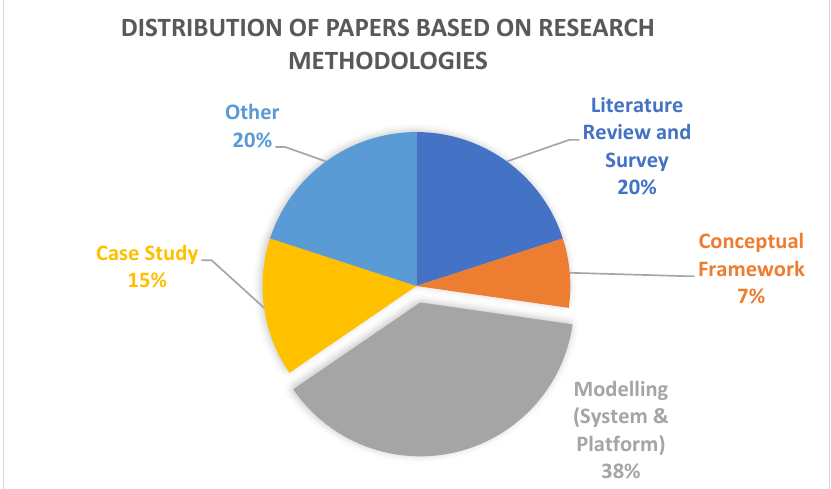
Figure 6. Research methodologies considered in the surveyed articles.